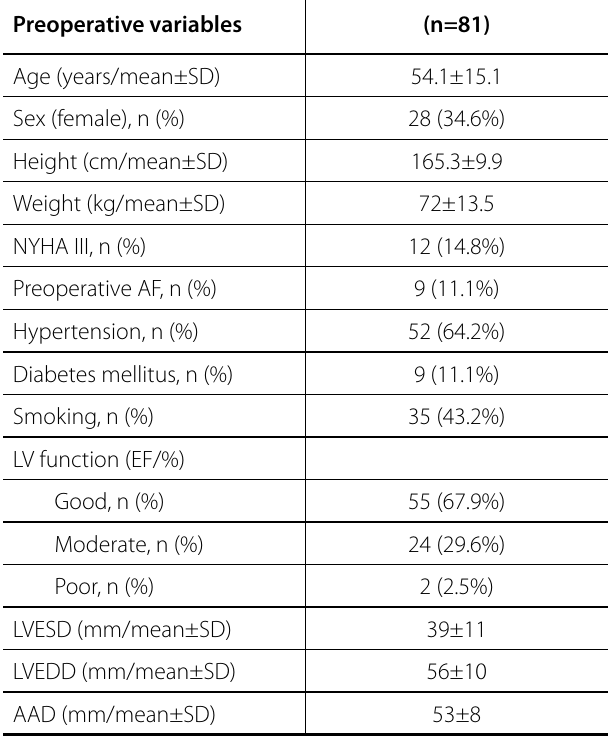
Table 1 . Demographic